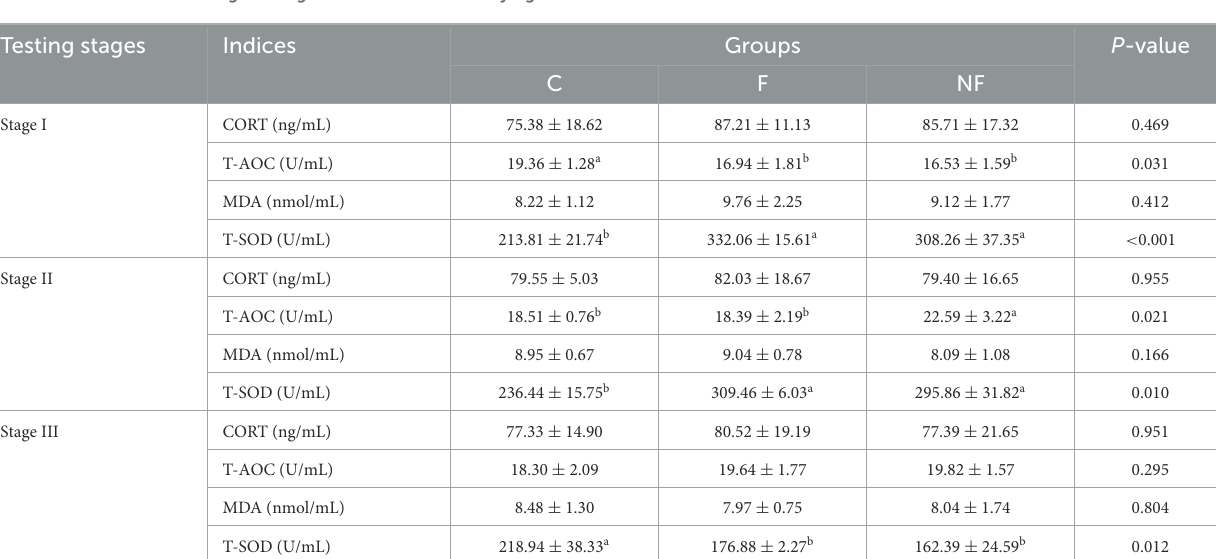
TABLE 3 Effects of non-fasting molting on oxidative stress in laying